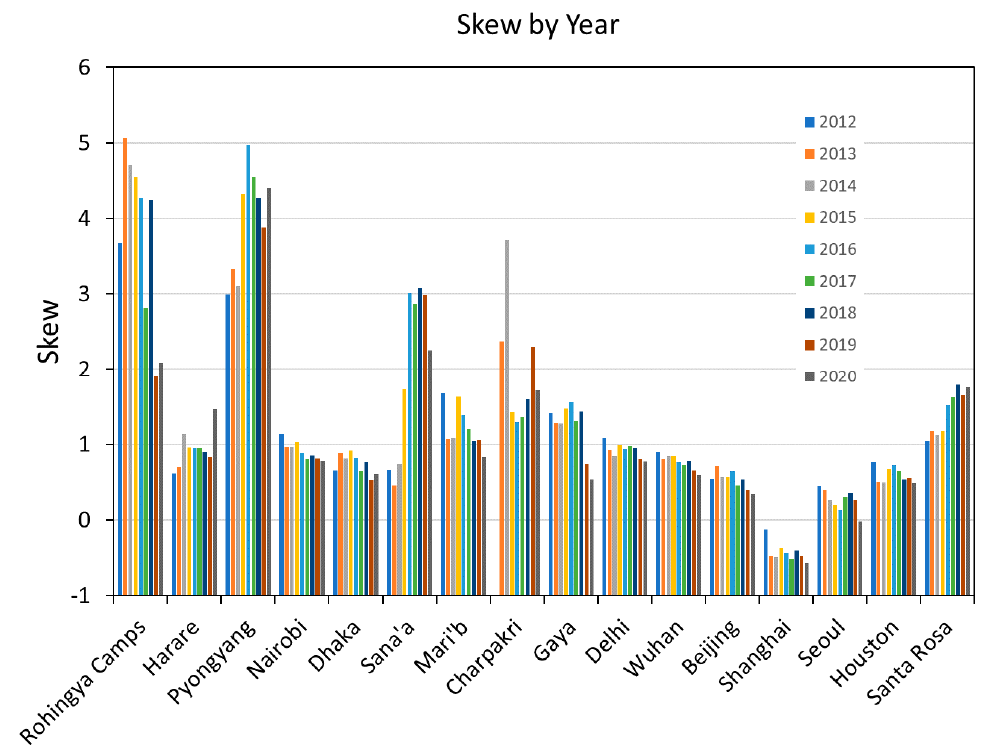
Figure 23. Picket-fence chart of the mean skew for each of the test sites by year.